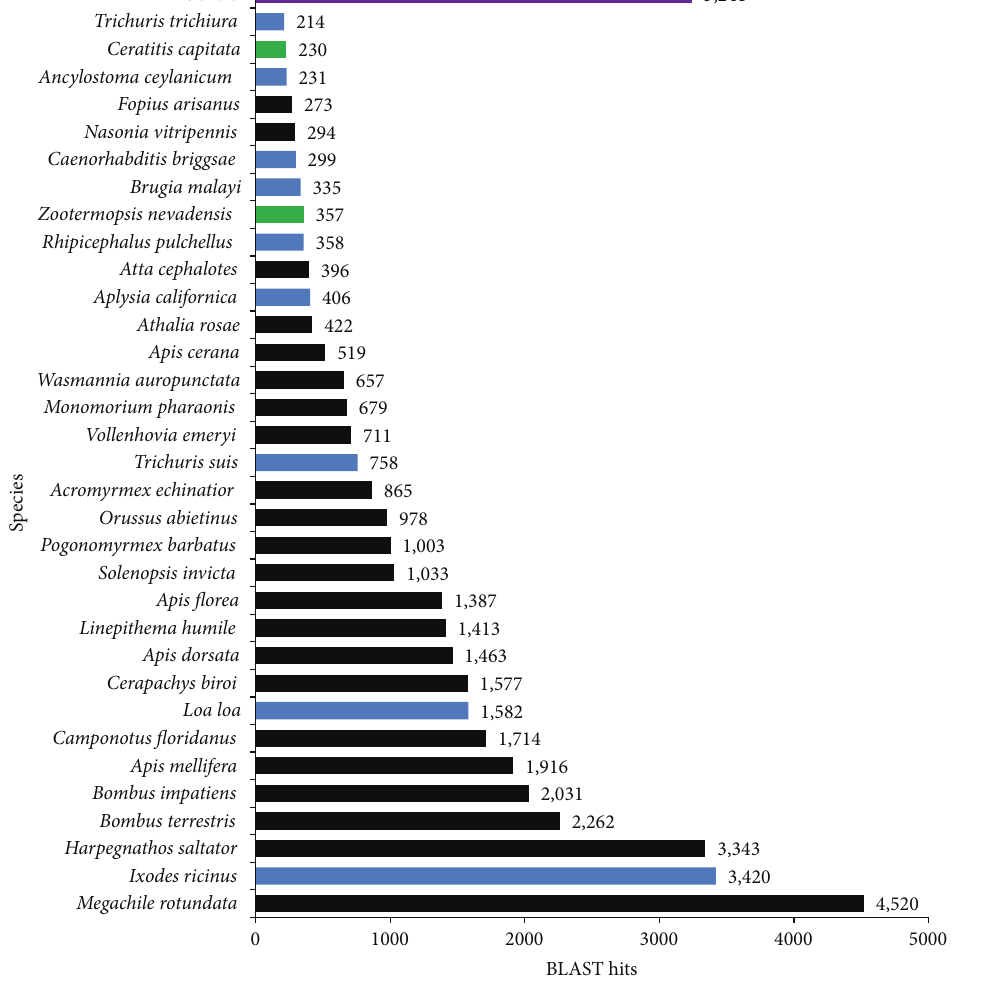
Figure 3: Top-hit species distribution for V. mandarinia unigenes against PANM-DB. The top-hit species belonging to class Insecta and order Hymenoptera are shaded black. The top-hit insect species not belonging to order Hymenoptera are shown by green bars. The top-hit species not belonging to class Insecta are shown by blue